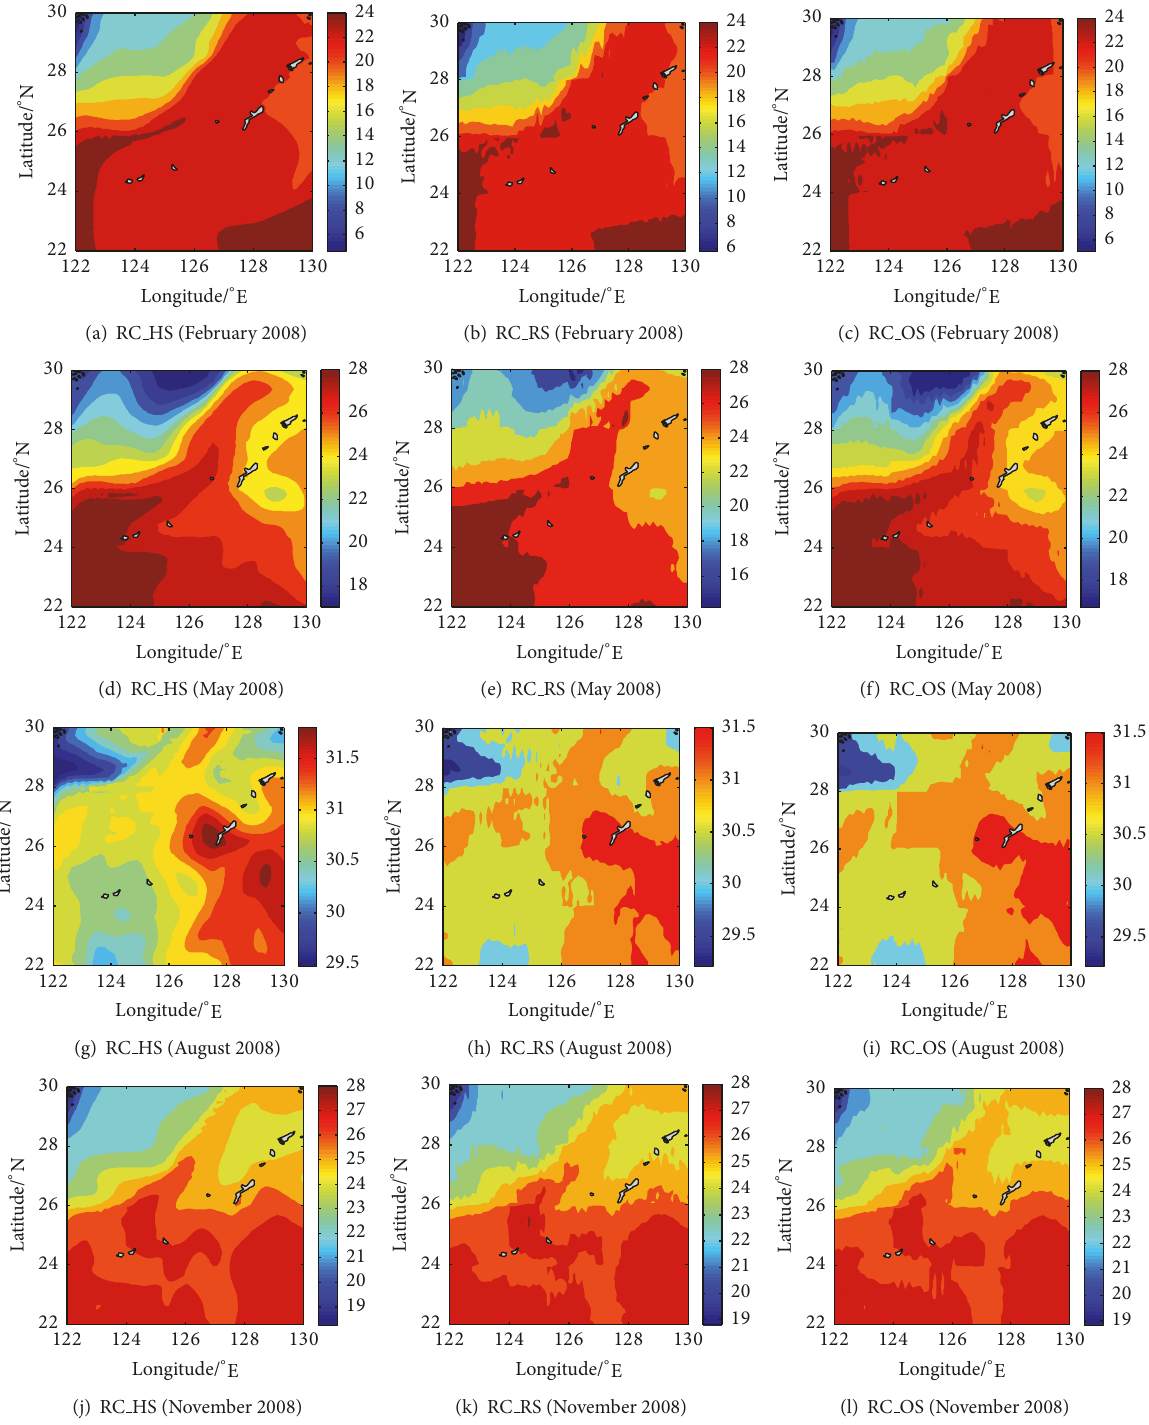
Figure 9: OS and RS reconstructed SST field in February, May, and